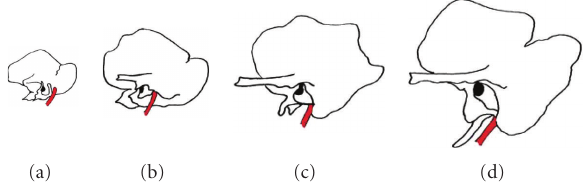
Figure 2: Development of the mastoid process. Schematic representations of the development of the temporal bone from infancy to adult- hood (from (a) to (b)). In the young infant, the mastoid is small, and the facial nerve, marked in red, is not yet covered by the mastoid process.